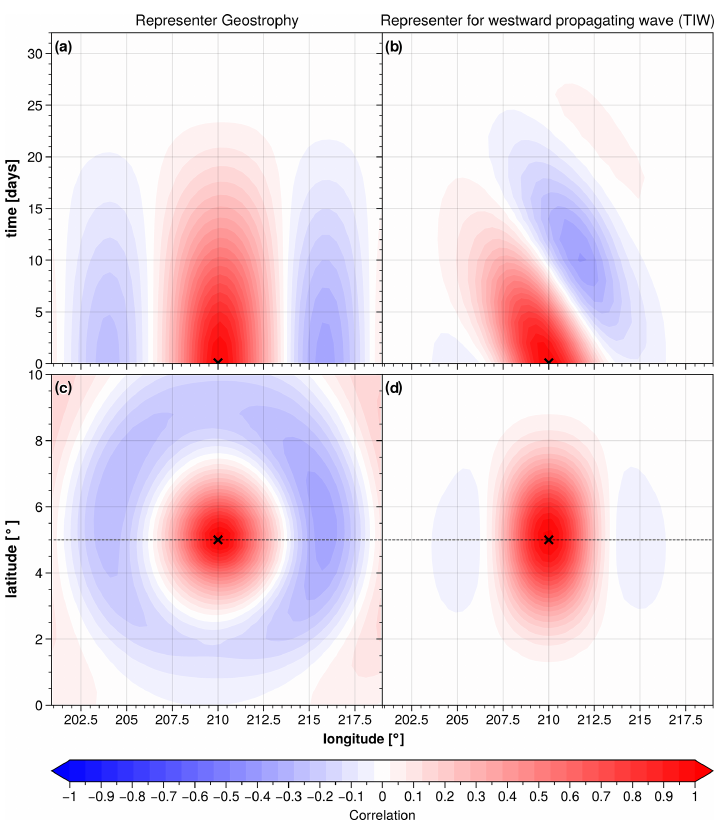
Figure 4. Example of spatio-temporal covariance models at (5 ◦ N, 210 ◦ E) for (a, c) the geostrophy component and for (b, d) a westward- propagating wave component, e.g.